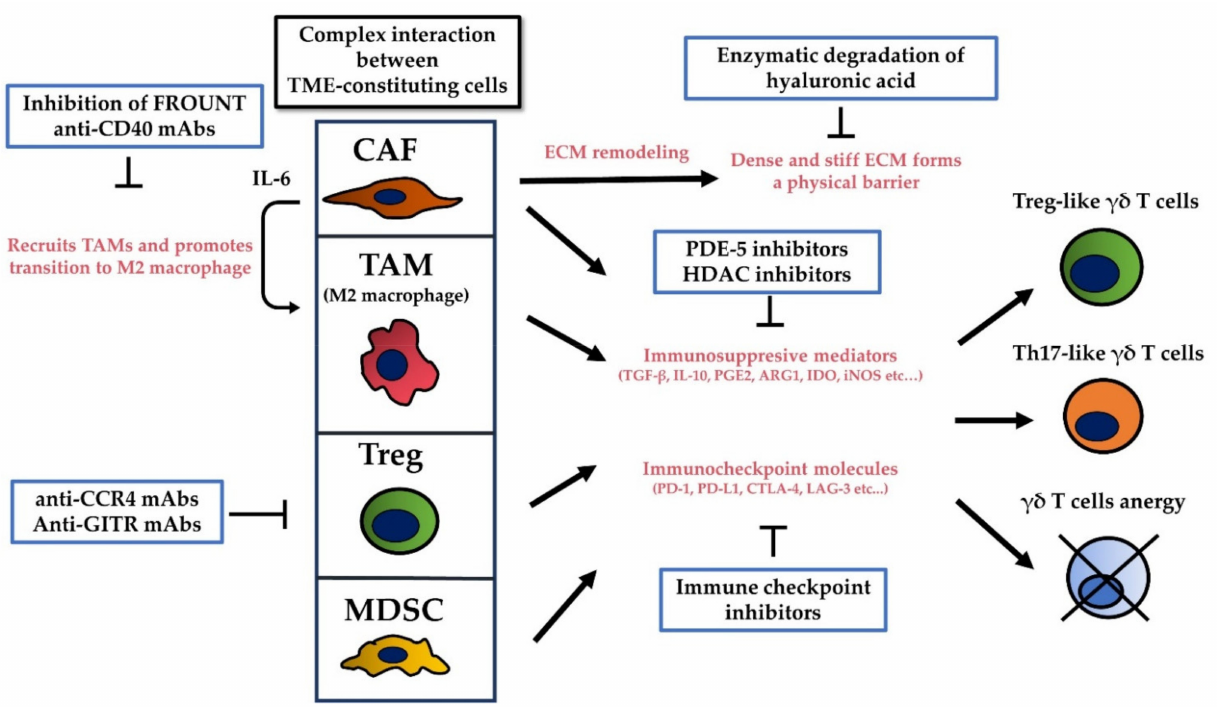
Figure 3. Cells in the TME induce polarization and anergy of γδ T cells in various ways (with red font) and some potential strategies to overcome negative effect from the TME are conceivable (in the blue